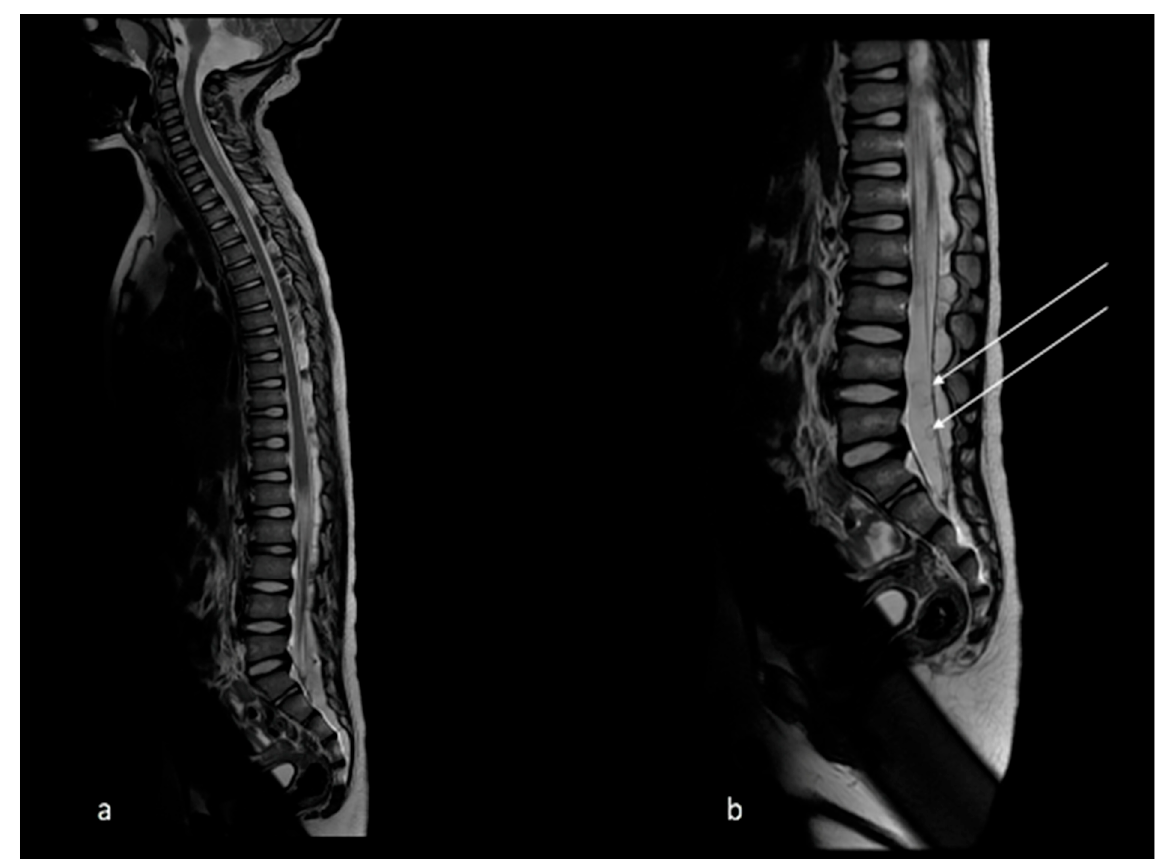
Figure 2. T2 sagittal MRI spine demonstrates ( a ) multiple cysts in the posterior spinal epidural space extending from lower cervical to the lumbar region with ( b ) smaller cysts within the subarachnoid space around filum terminale (arrows).